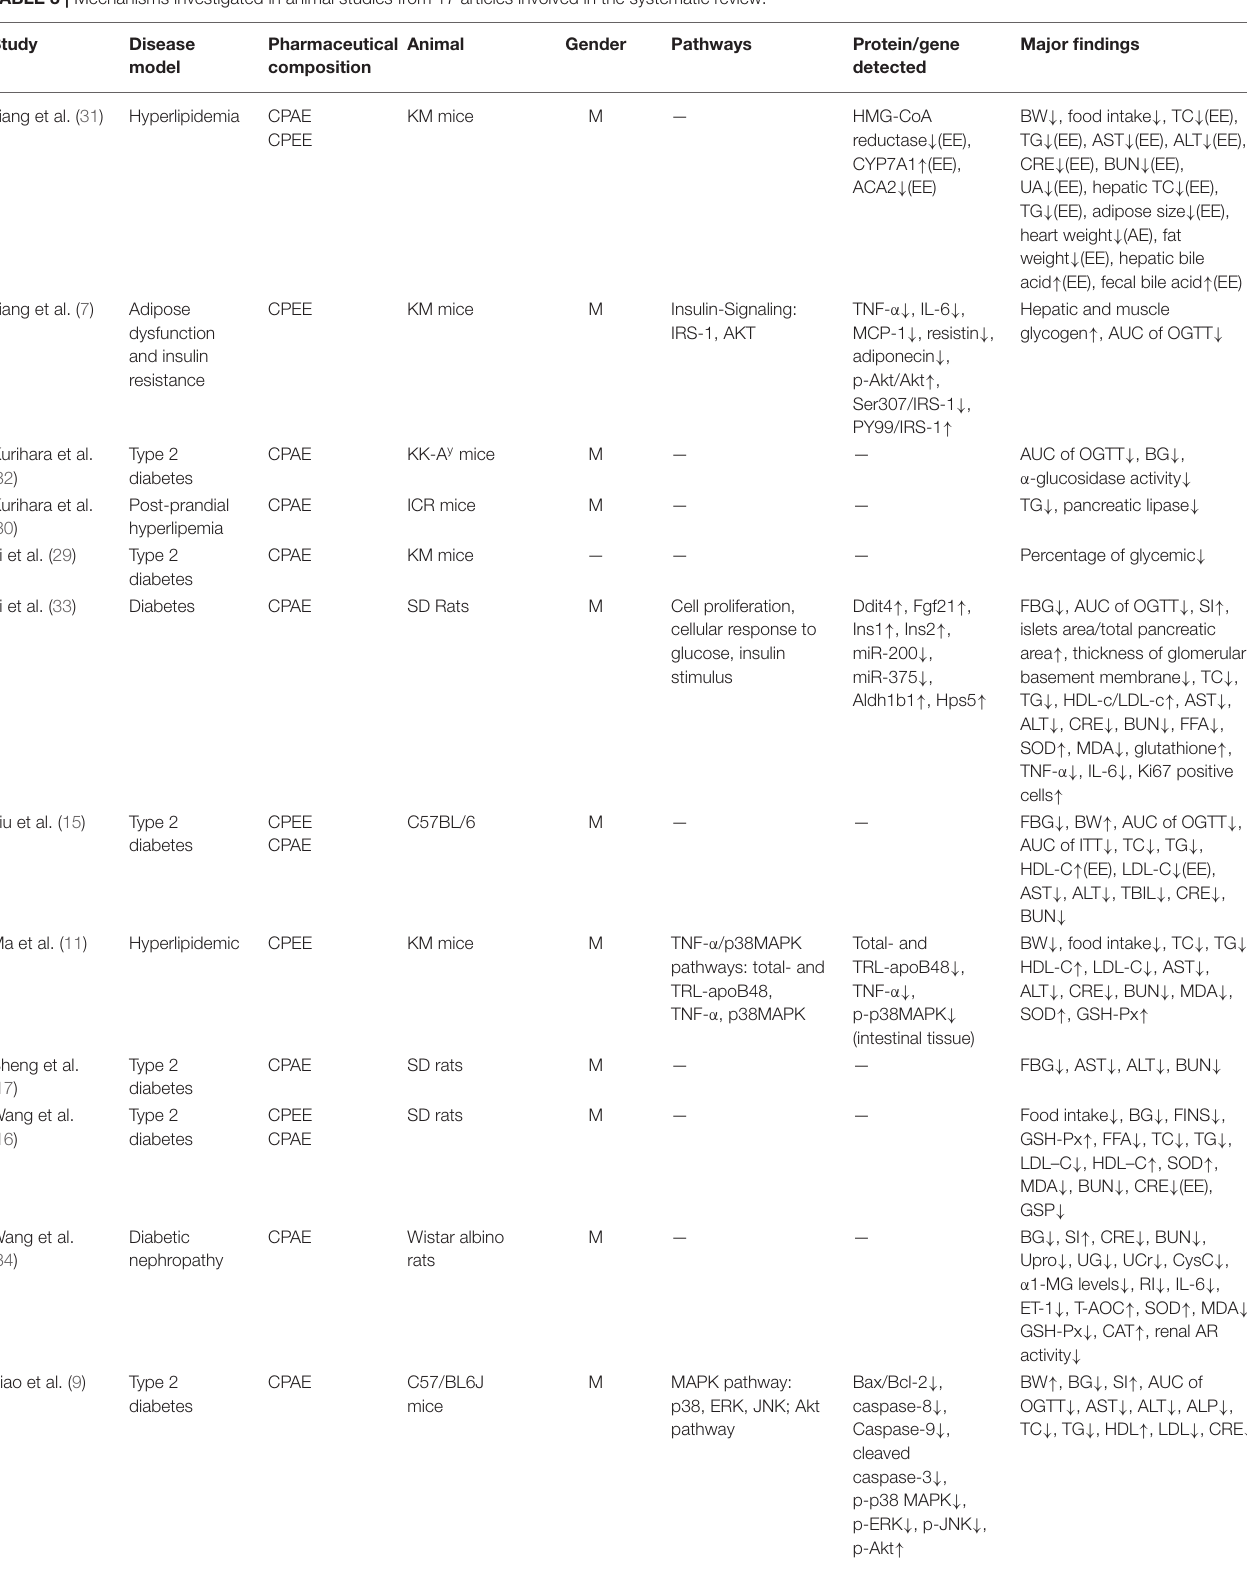
TABLE 3 | Mechanisms investigated in animal studies from 17 articles involved in the systematic